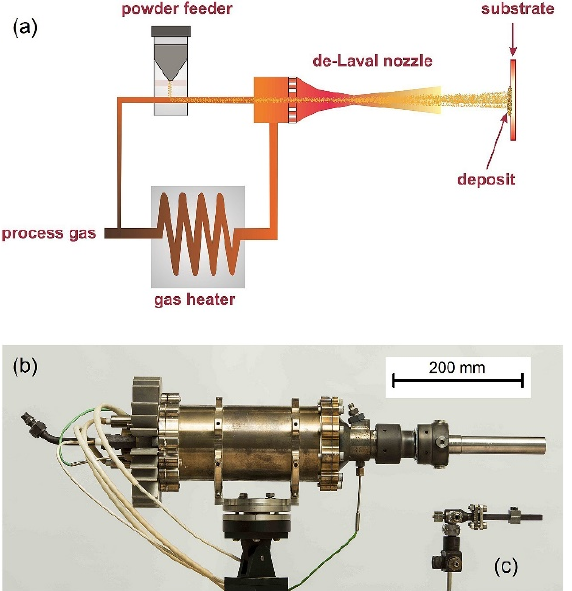
Figure 2. An overview of a high-pressure cold spray system. ( a ) Schematics of the main components of the original system, ( b ) a commercialized cold spray gun/nozzle, and ( c ) an original gun/nozzle [33].